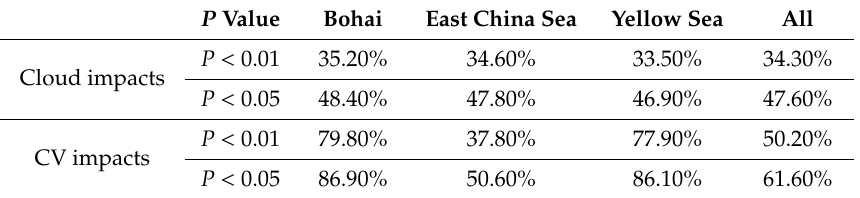
Table 2. Area percentage statistics: P value for each subregion at the hourly scale.